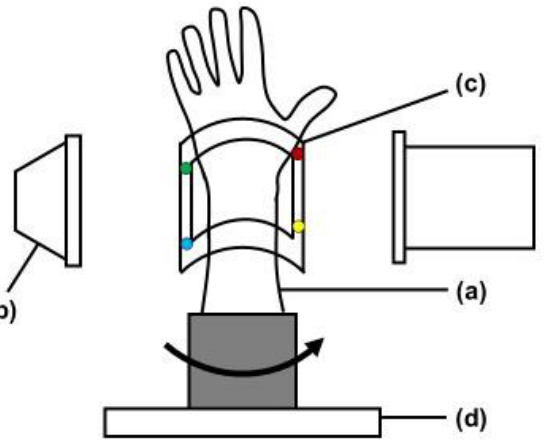
Figure 1. Experimental setting of bone model. ( a ) Bone model. Bone models were covered with X-ray transparent elastic material that imitated skin. ( b ) Position of the image intensifier of fluoroscopy. ( c ) Splint to position the markers. The splint was attached to the bone model. Colored circles indicate the position of each marker. ( d ) Turntable to rotate the bone model.